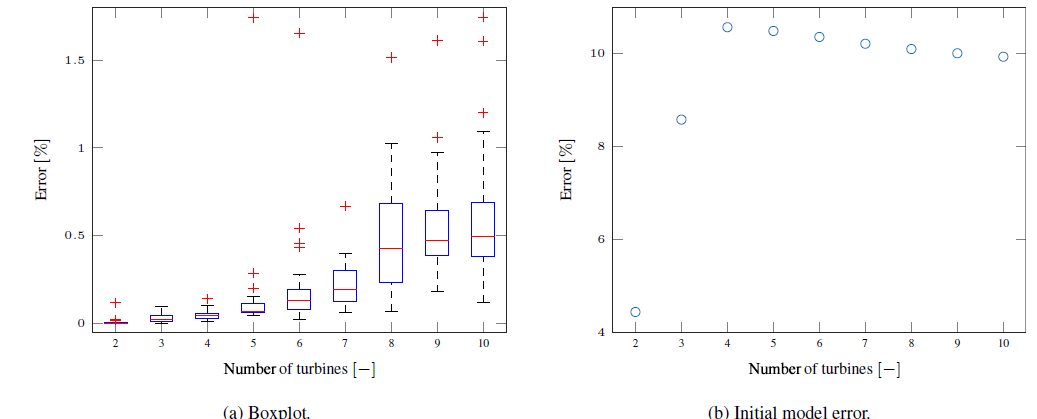
Figure 6. (a) The boxplot of the optimization results for the differently long wind turbine rows on the left. The red line indicates the median. The bottom and top edges of the blue box indicate the 25th and 75th percentiles, respectively. The red markers indicate outliers, and the whiskers extend to the most extreme data points not considered as outliers. The error in the MA–GP approach and the initial error are dependent on the number of turbines in the row. (b) The initial error in the model depending on the number of turbines in the